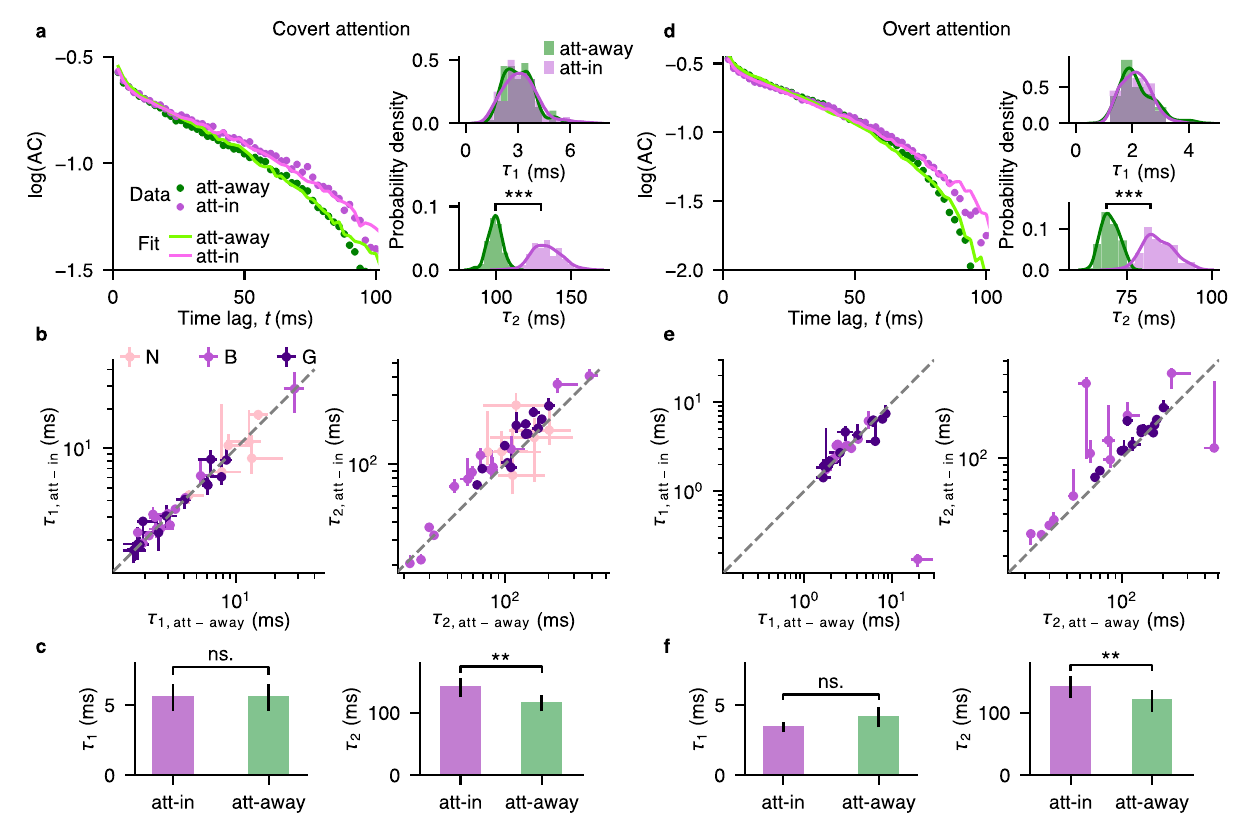
uncertainty. Number of included sessions (in which autocorrelations were better fi ttedwithM fi ttedsessionsforeachmonkey: N N 2 )fromthetotal G =13/19, B =13/13, N N =6/12.Color ofthedots indicates different monkeys. c Across sessions, the fast timescale ( τ 1 , left) did not change, while the slow timescale ( τ 2 , right) signi fi cantly increased during covert attention (magenta) relative to the attend-away condition (green). Bar plots show the mean±s.e.m of MAP estimates across sessions. Statis- =0 : 75, p τ =3×10 (cid:2) 4 . ns., **, *** indi- tics: two-sided Wilcoxon signed-rank test, p τ 1 2 cate p >0.05/4, p <10 − 2 , p <10 − 3 , respectively (Bonferroni corrected for 4 comparisons).Individualdatapointsareshownin b . d – f Sameas a – c butduringthe overt attention for a different example session. Number of included sessions from the total fi tted sessions for each monkey: N G =14/19, N B =12/12. Statistics: d p τ =0 : 07, p τ <10 (cid:2) 10 , (f) p τ =0 : 39, p τ =7×10 (cid:2) 4 . Source data are provided as a 1 2 1 2 Source Data fi